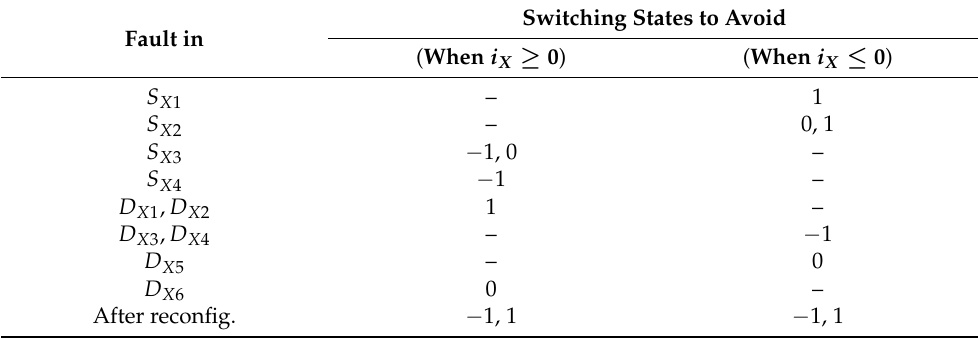
Table 2. Switching States Affected by each Fault in Phase X (to be Avoided by the Controller). Switching States to Avoid Fault in ( When i X ≥ 0 ) ( When i X ≤ 0 ) S X 1 – 1 S X 2 – 0, 1 S X 3 − 1, 0 – S X 4 − 1 – D X 1 , D X 2 1 – D X 3 , D X 4 – − 1 D X 5 0 D X 6